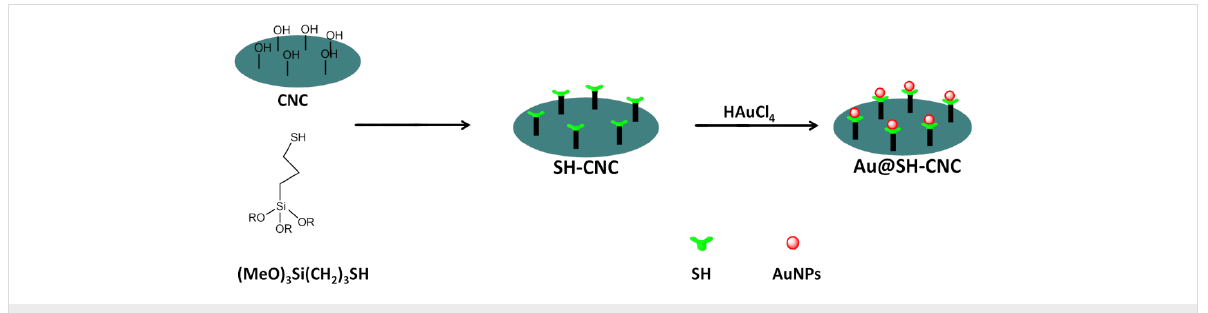
Scheme 1: Sketch illustrating preparation of the Au@HS-CNC